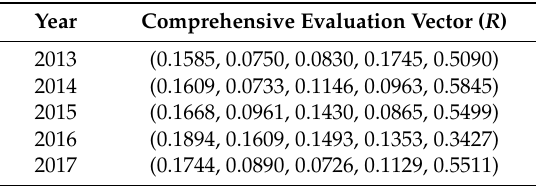
Table 5. Comprehensive evaluation vector of water